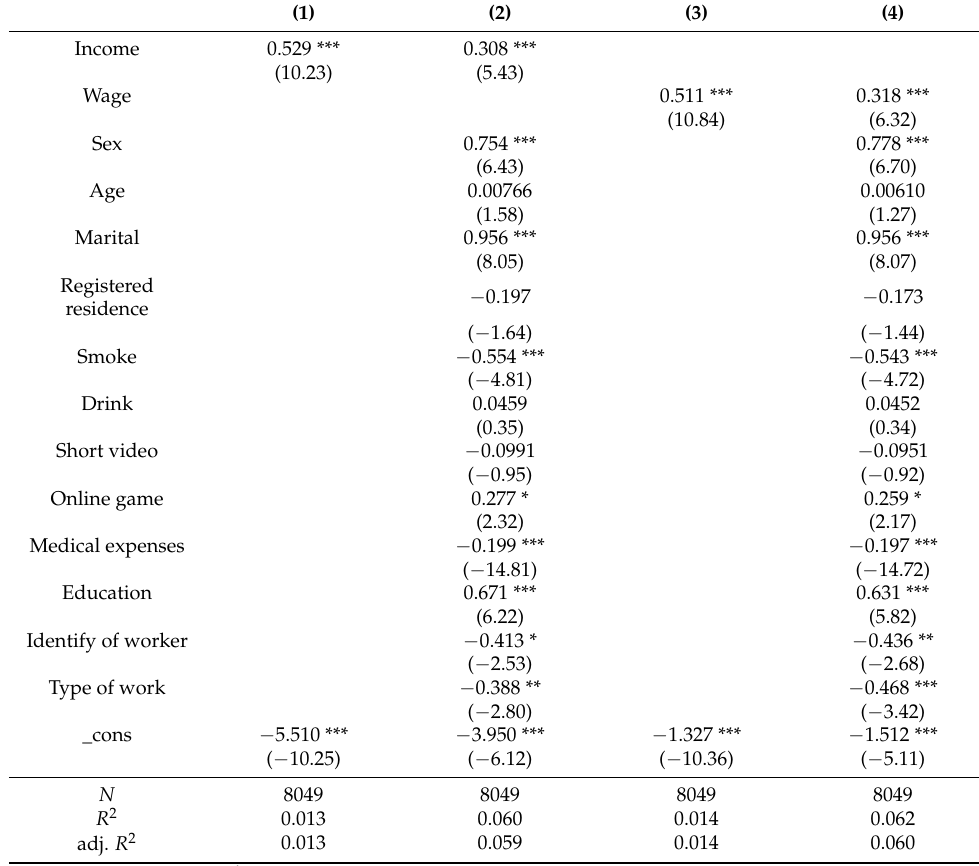
Table 3. OLS results of the effects of income on mental